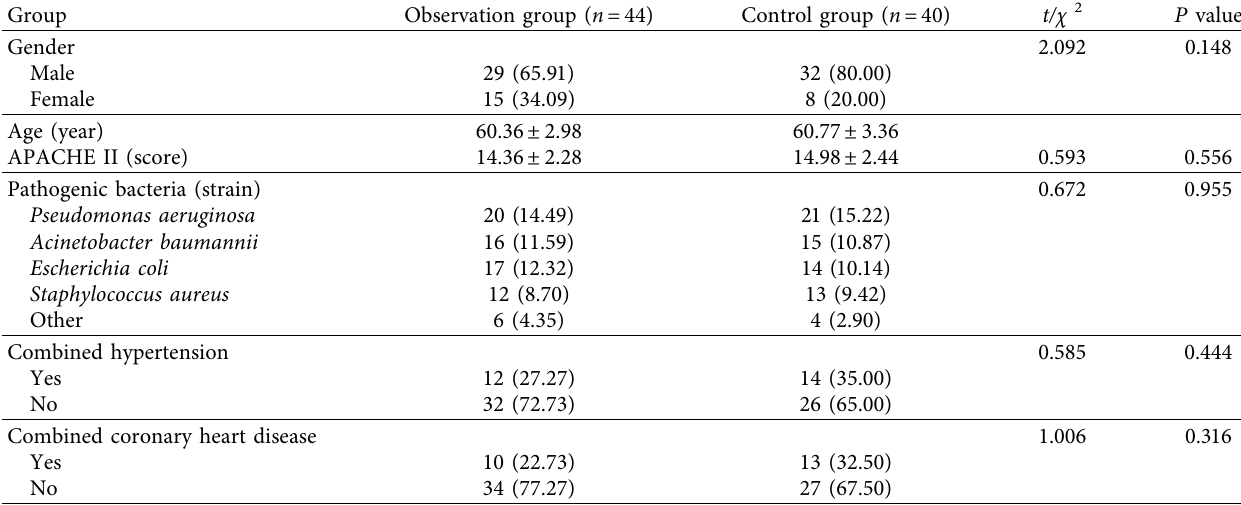
Table 1: Comparison of general data of the two groups of patients ( ± s ).